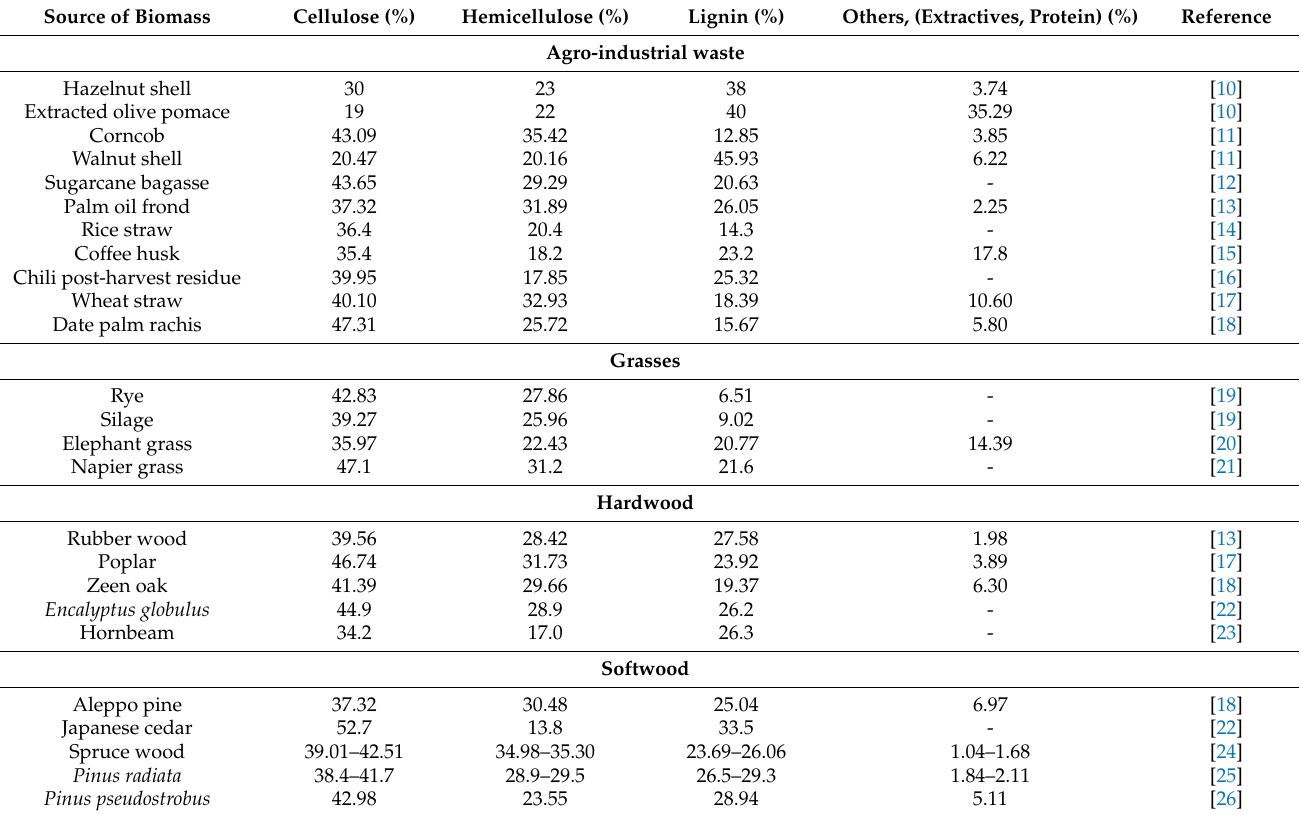
Table 1. Chemical composition of a variety of lignocellulosic biomass (% dry weight). Source of